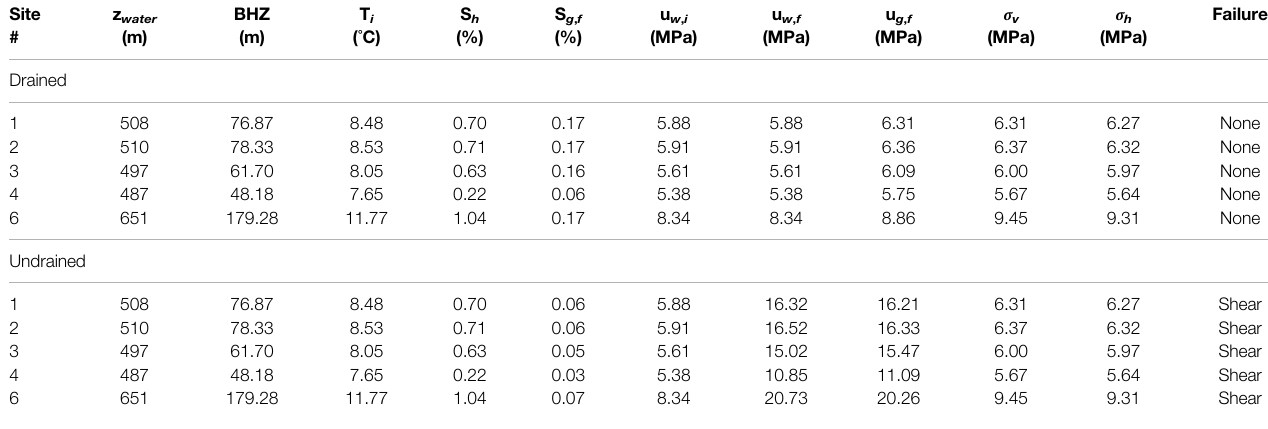
TABLE 6 | Geomechanical Model: Pressures and stresses due to hydrate dissociation along the shelf edge. An increase in temperature by 1 ° C was used to initiate dissociation for both the drained and undrained models. Site